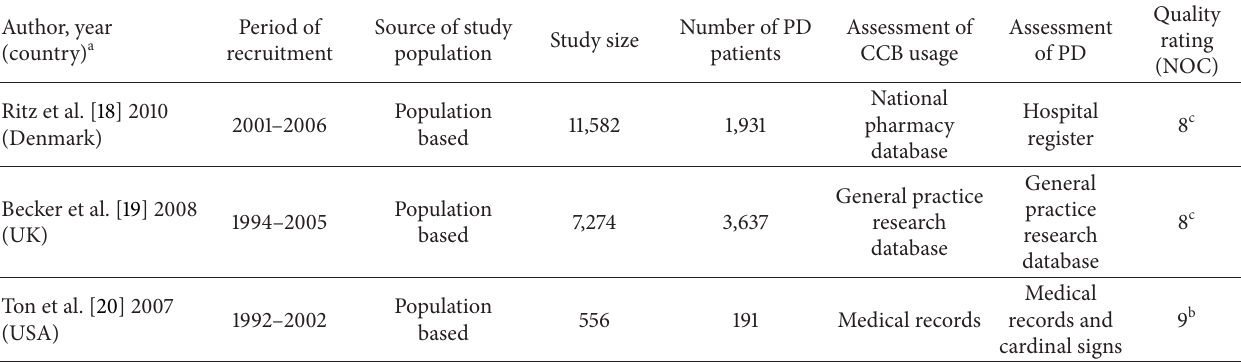
Table 2: Characteristics of case-control studies included in